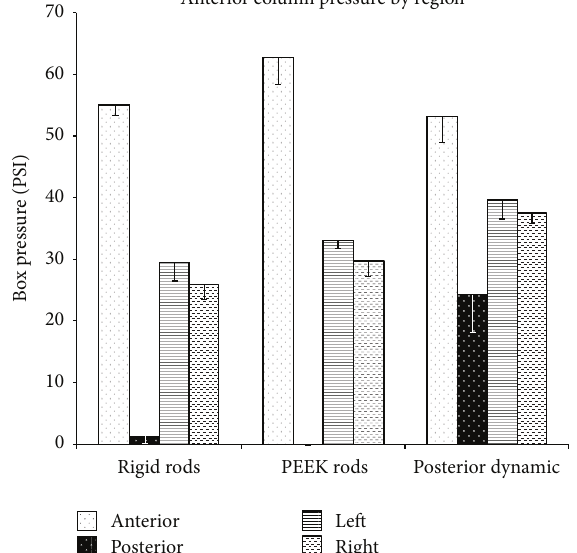
Figure 9: Average box pressure of the anterior, posterior, left, and right portions of the spacer as measured through the pressure film (according to Figure 4).